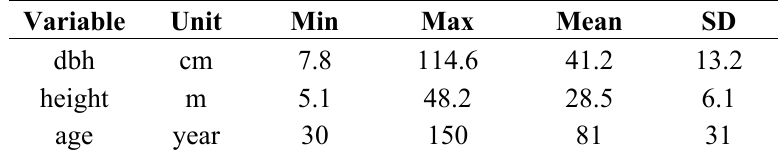
Table 1. Characteristics of dominant spruces with height measurements in the NFI